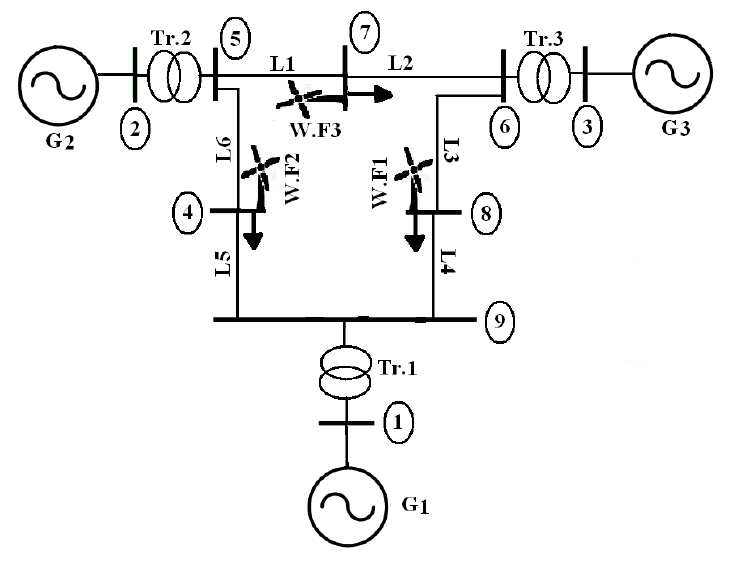
Figure 1. Single-line diagram of the nine-bus